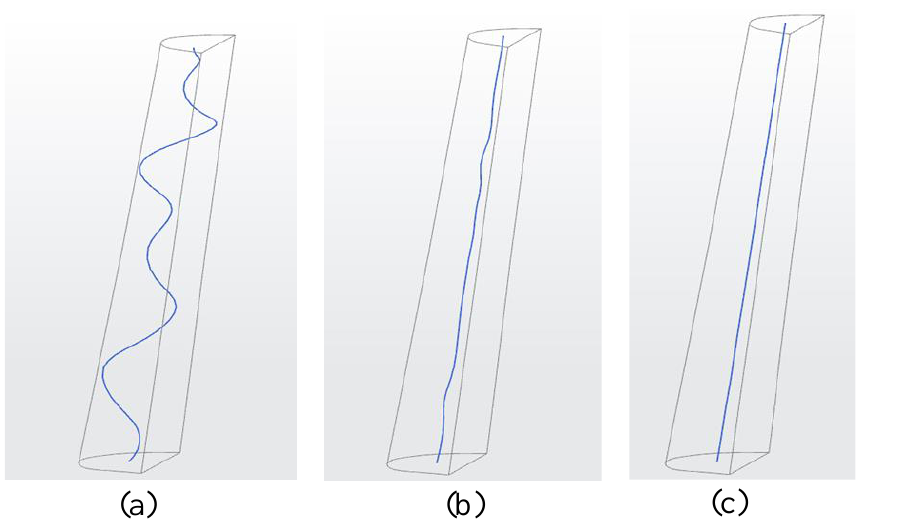
Figure 8. Iterative optimization results of the single-channel flow path skeleton line: ( a ) Original flow path skeleton line; ( b ) Skeleton line obtained by one iteration; ( c ) Final optimized skeleton